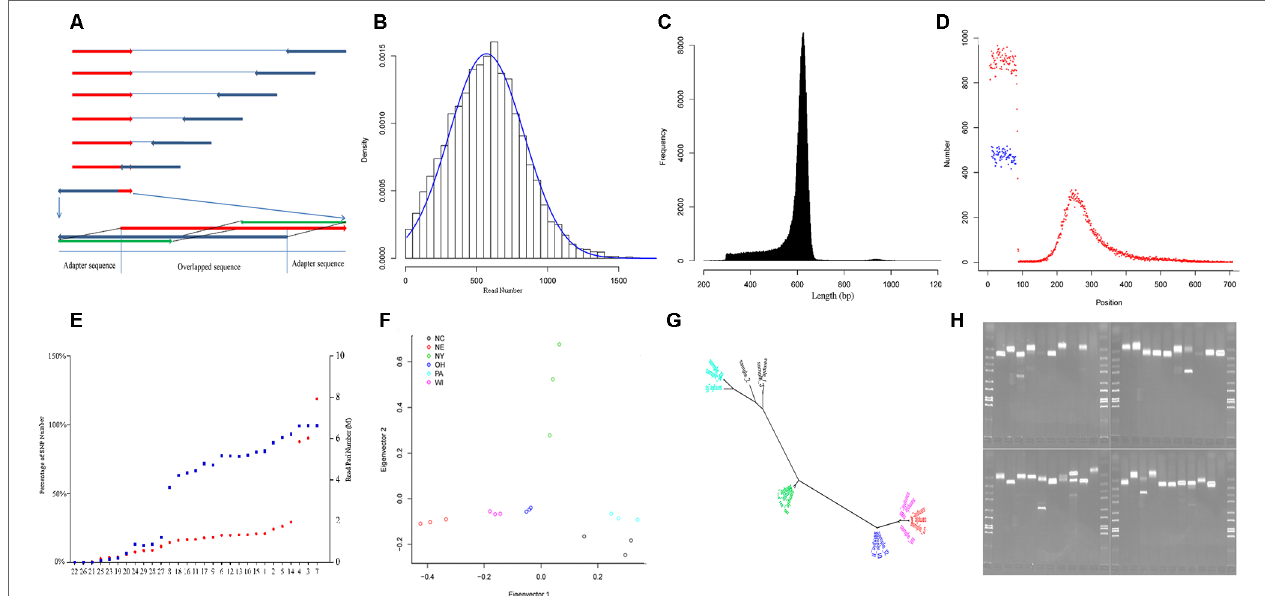
FIGURE 1 | Characteristics of yellow perch RAD-Seq. (A) Illustrating the removal of adaptor sequences at the 3 ′ end of read. The red arrows show the forward reads, and blue arrows show the reverse reads. Usually, each read contains adaptor sequence at the 5 - end and removed routinely. The adaptor sequence would appear in 3 ′ end when the read length is longer than the library size. Based on the characters of rare Indel and overlapping genome sequence fragment, the 5 ′ end sequence fragment probe (green) in the forward read (red) was used to scan the reverse read (dark blue) in the direction from 3 ′ end to 5 ′ end with a step size of 1 bp. Once the distance fell below a certain threshold value, the sequence fragment located on the 3 ′ end of the matched sequence fragment was treated as an adapter and then removed. The scan was also applied to the forward read. (B) The read number that clustered for each RAD-tag. The blue line shows the expected distribution fitting Gaussian distribution. (C) The distribution of final contig length. (D) The distribution of SNPs along the contig (red points: SNPs in the first dataset, blue points: SNPs in the second dataset). (E) The percentage of SNP number for each individual in the whole SNPs (blue points, left axis) in the first dataset and read pair number for each individual after removing duplication (red points, red axis). The nine individuals with less than 50% of total SNPs were removed in population genetics. (F) The distribution of the 18 individuals from six strains ( Table 1 ) along the first and second principal components. (G) The phylogenetic tree for the same individuals in graph G with the same color schedule. (H) The electrophoretogram for the 40 randomly chosen SSRs. The last second lane on the right- down figure is negative control without primer